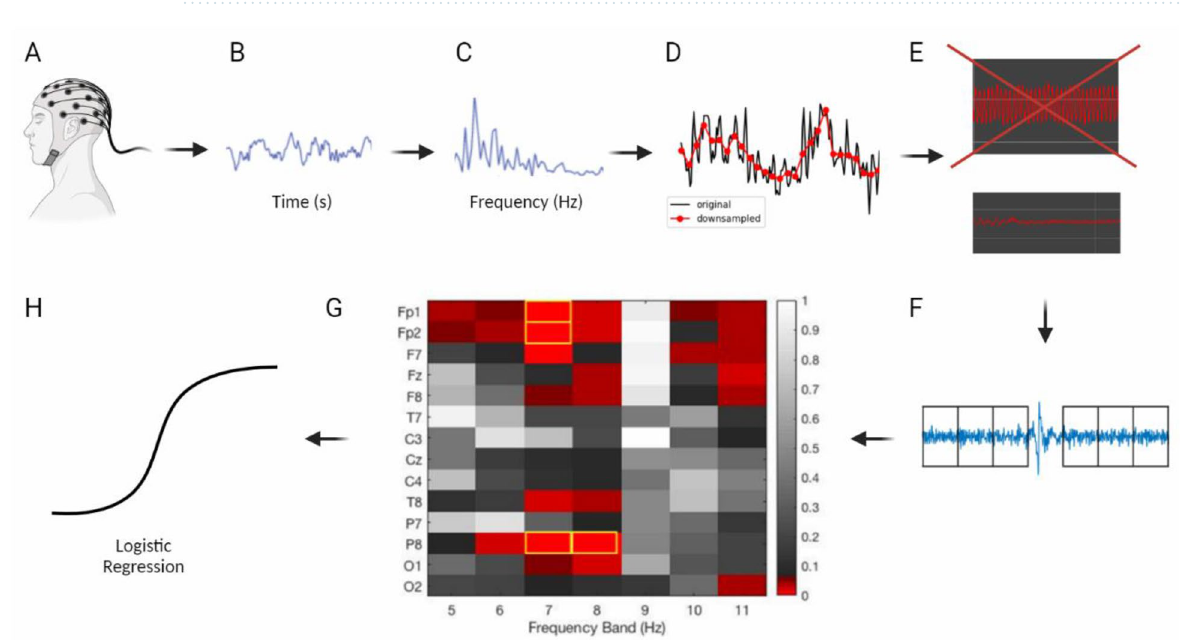
Figure 3. Summary of Automated Pipeline: ( A ) EEG collection ( B , C ) transformation from time domain to frequency domain ( D ) frequency downsampling ( E ) removal of low-quality channels ( F ) automated support vector machine-based artifact detection and removal ( G ) feature extraction and selection ( H ) input into ML model (logistic regression). Figure created with